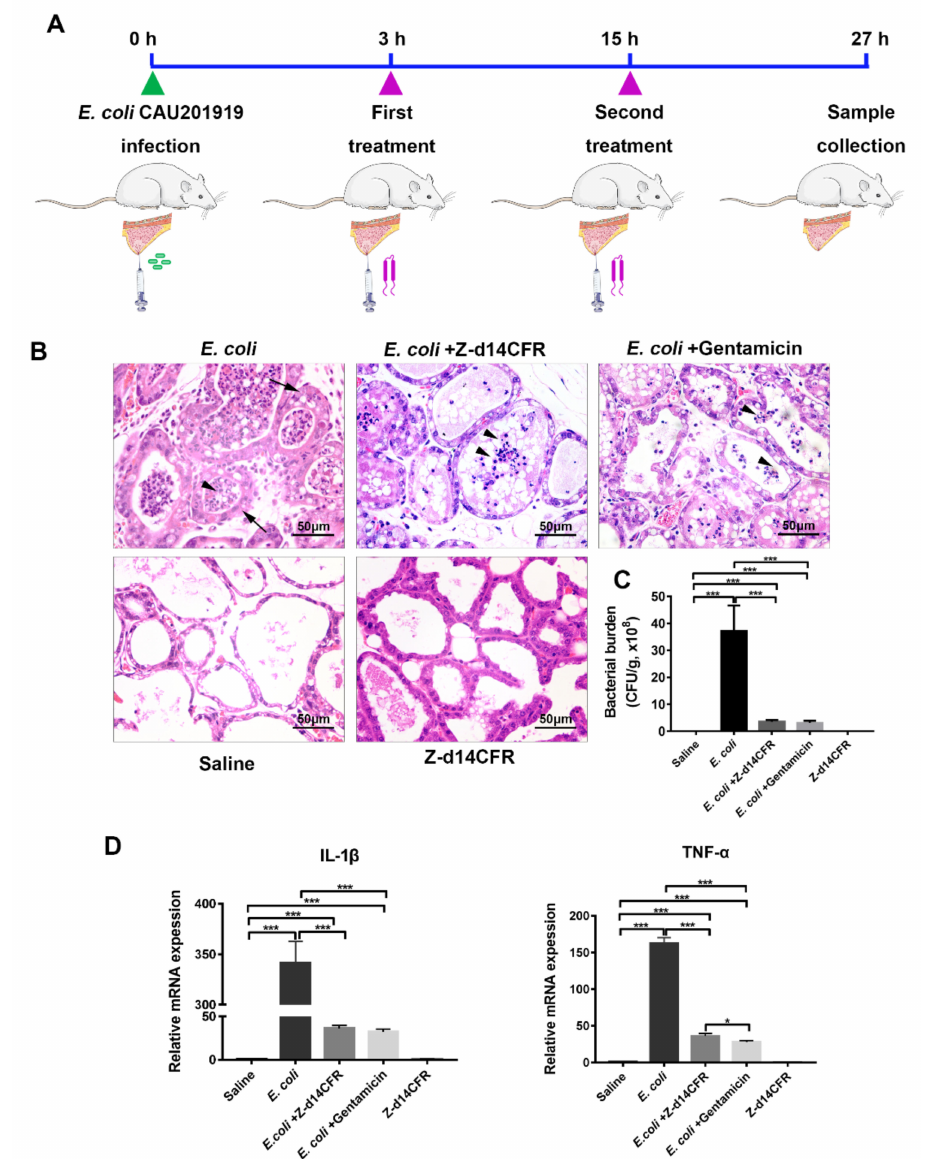
Figure 7. A murine model of multidrug-resistant E. coli -induced mastitis treated with or without Z-d14CFR. ( A ) Experimental protocol of murine mastitis model induced by multidrug-resistant E. coli CAU201919. ( B ) Histopathologic changes of the mammary gland. Long arrows indicate the thickening of mammary acinar walls, short arrows indicate neutrophils infiltration in acinar cavity. ( C ) Bacterial burden in the mammary gland of mice. ( D ) IL-1 β and TNF- α mRNA expression